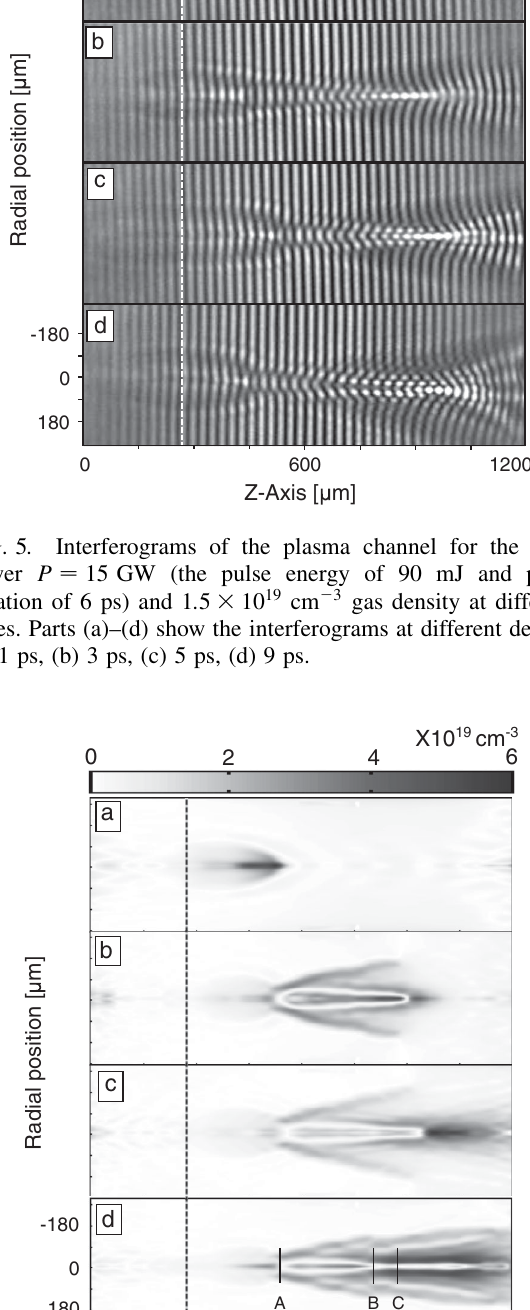
Fig. 12. At the pulse duration of 0.3 ps, the length of the plasma channel is as long as 600 (cid:1) m as shown in Fig. 12(a). It is approximately 3 times longer than the Raleigh length. The length decreases with pulse duration down to 400 (cid:1) m for 6 ps pulse duration. The opposite dependency is observed for the channel diameter; being about 15 (cid:1) m in the case of 0.3 ps pulse duration, it increases up to 37 (cid:1) m for 6 ps duration pulses as shown in Fig. 12(b). The channel depth (the ratio of maximal and minimal electron density) is not monotonic, Fig. 12(c). It falls from (cid:1) 50 to 25 when the duration increases form 0.3 to 1.7 ps. Then it increases again to the factor of 35. We attribute this to decreasing of ponderomotive force with laser intensity decrease, as (cid:3) (cid:4) 1 , where (cid:3) is the pulse duration, and to the growing effect of elastic collisions which result in the electron heating at a longer pulse duration. Figure 13 gives insight into the difference be- tween the channels formed by shorter and longer laser pulses after 9 ps of plasma relaxation. For the highest